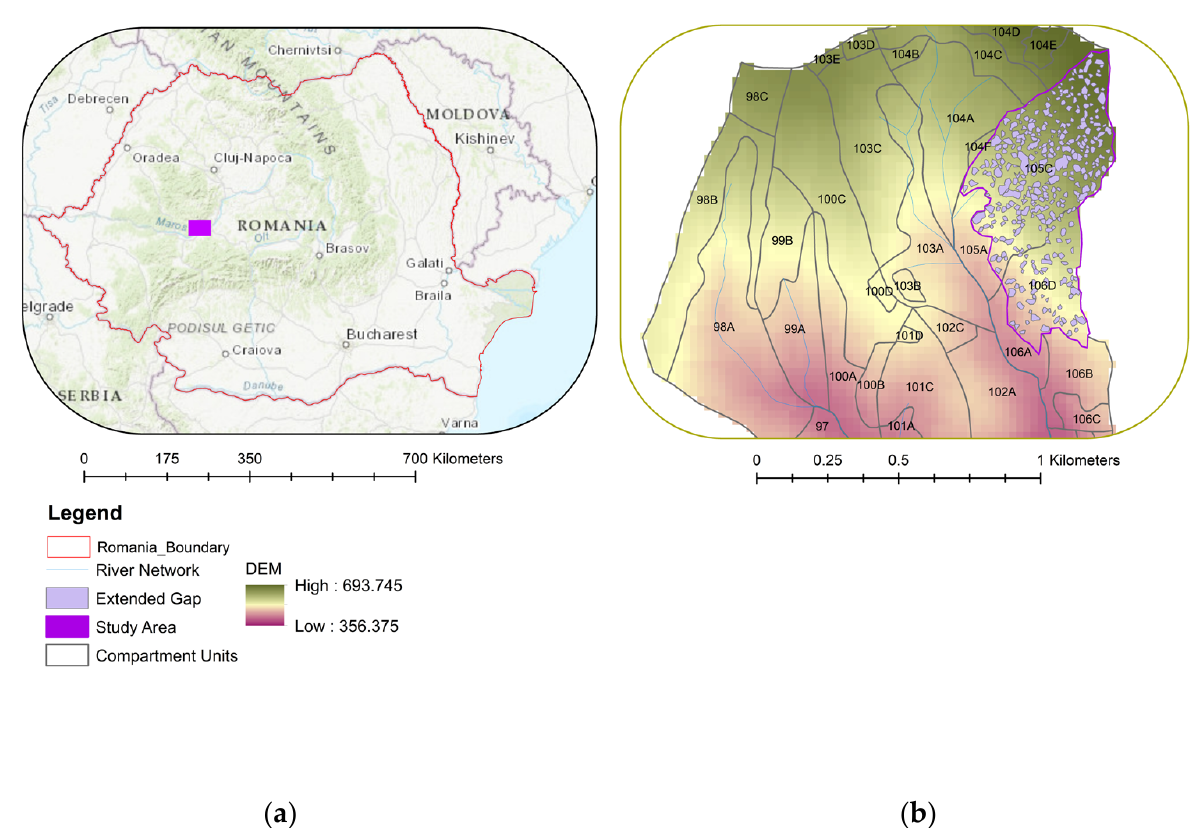
Figure 1. Location of Runcu-Grosi Natural Reserve. ( a ) Studied area with the canopy gaps mapped terrestrially. ( b ) (Sources of left panels: Esri, DigitalGlobe, GeoEye, i-cubed, USDA FSA, USGS, AEX, Getmapping, Aerogrid, IGN, IGP, swisstopo and the GIS User Community).